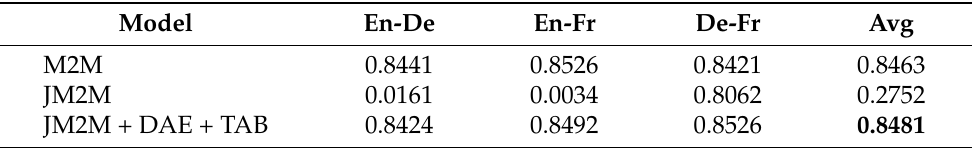
Table 2. Cosine similarity scores of sentence embeddings for three parallel language pairs. The highest score in the average column is in